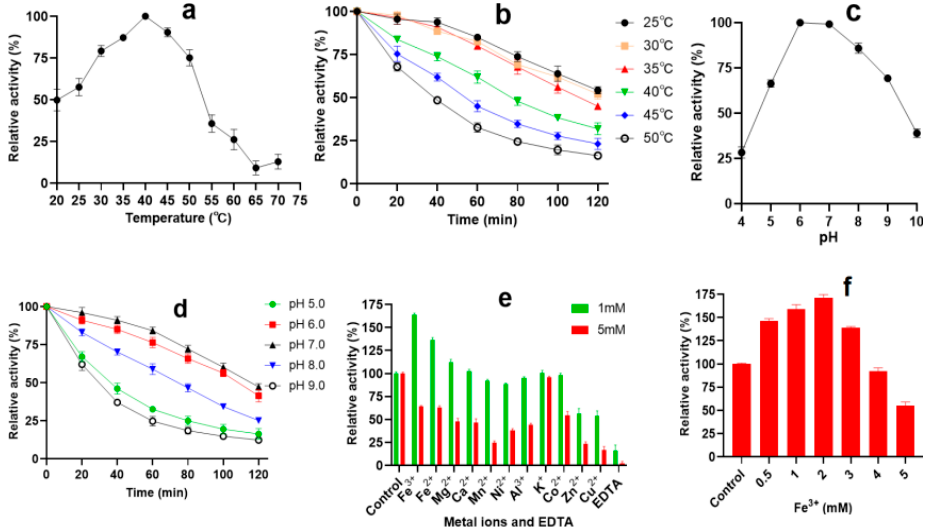
Figure 7. The influence of temperature and pH on the activity of NiR-A2: ( a ) optimum tempera- ture; ( b ) thermostability; ( c ) optimum pH; ( d ) pH stability; ( e ) metal ions and EDTA; ( f ) different concentrations of Fe 3+ .